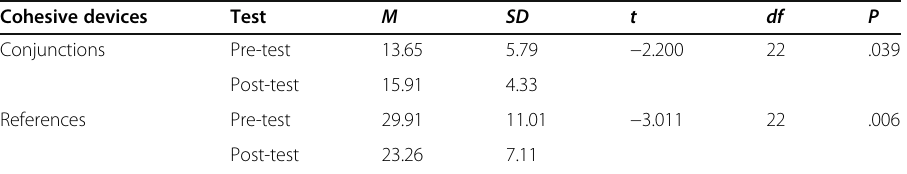
Table 2 Mean frequency, standard deviation, and paired sample T-test results for conjunctions